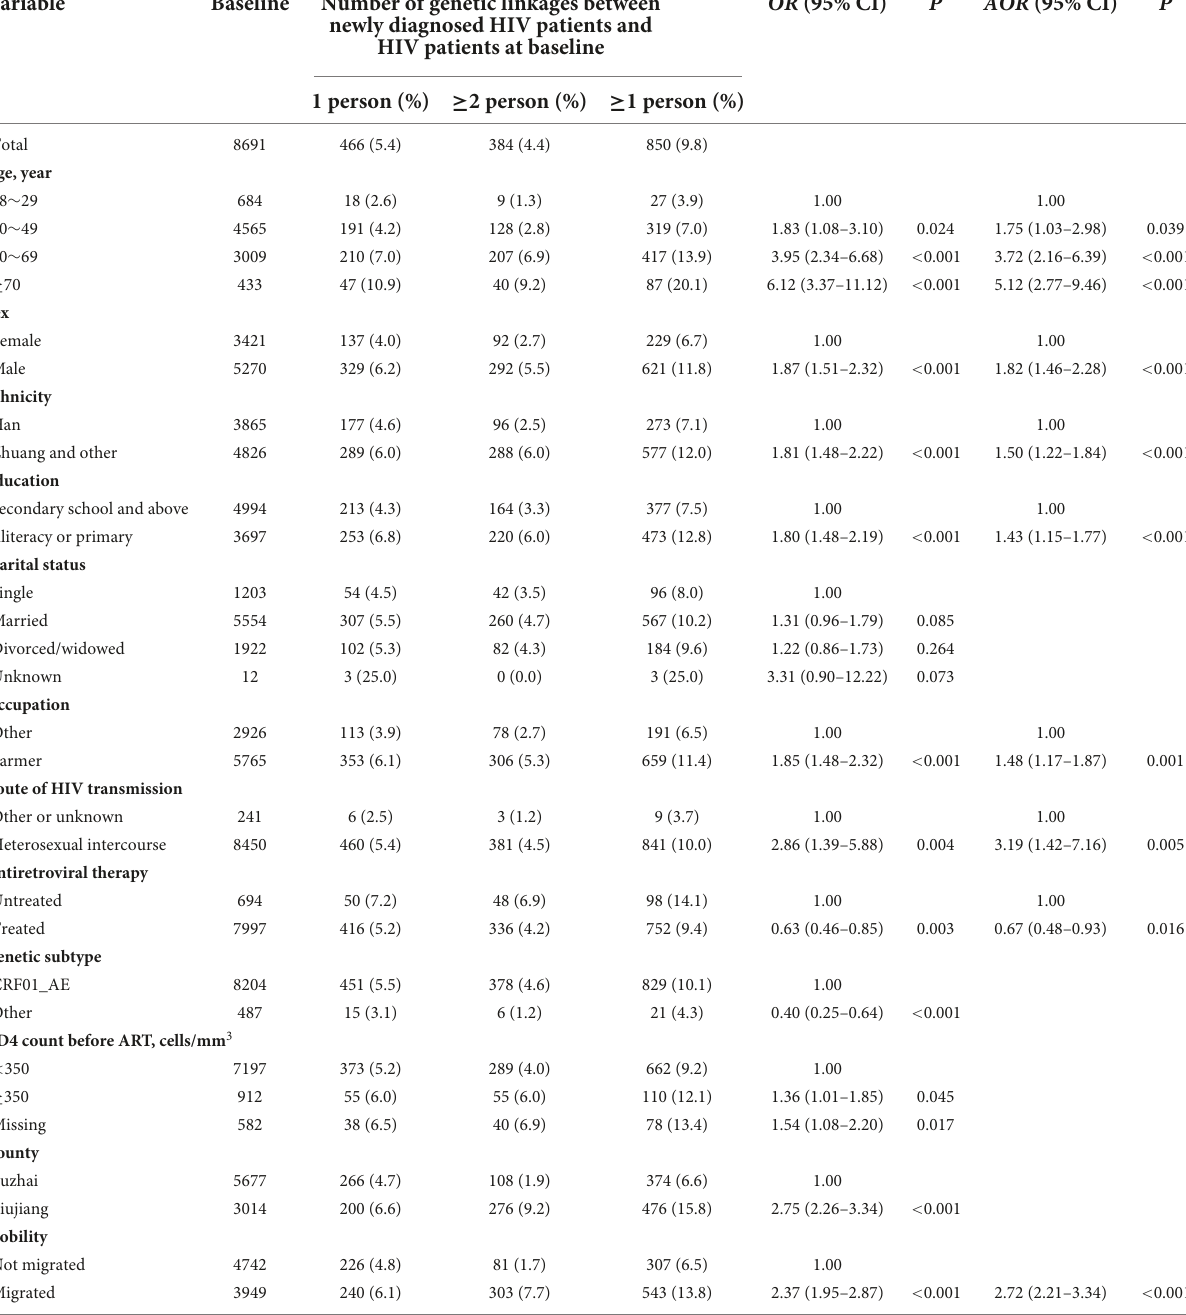
TABLE 2 Genetic linkage between newly diagnosed patients with HIV during 2016–2018 and those at baseline during 2015–2017 in Guangxi of China,